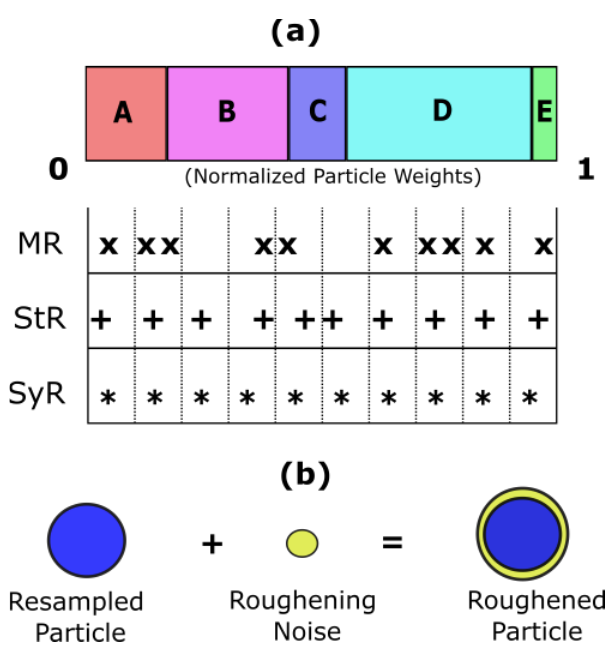
Figure 4. ( a ) The schematic representation of different resampling strategies used in this work — Multinomial Resampling (MR), Stratified Resampling (StR), and Systematic Resampling (SyR); and ( b ) the schematic representation of particle roughening weight regularization